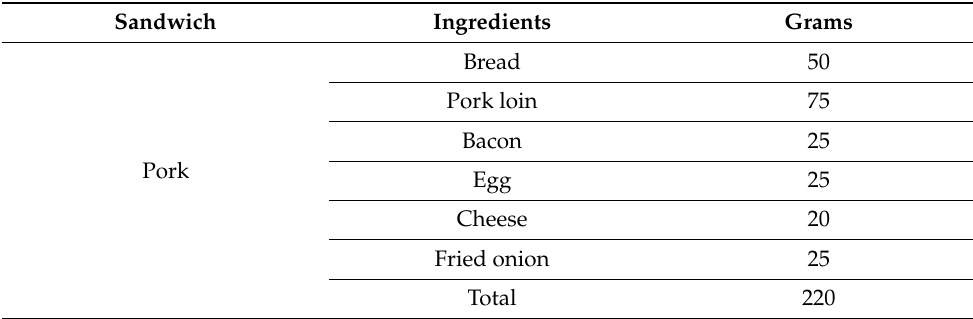
Table 4. List of ingredients and weight of designed